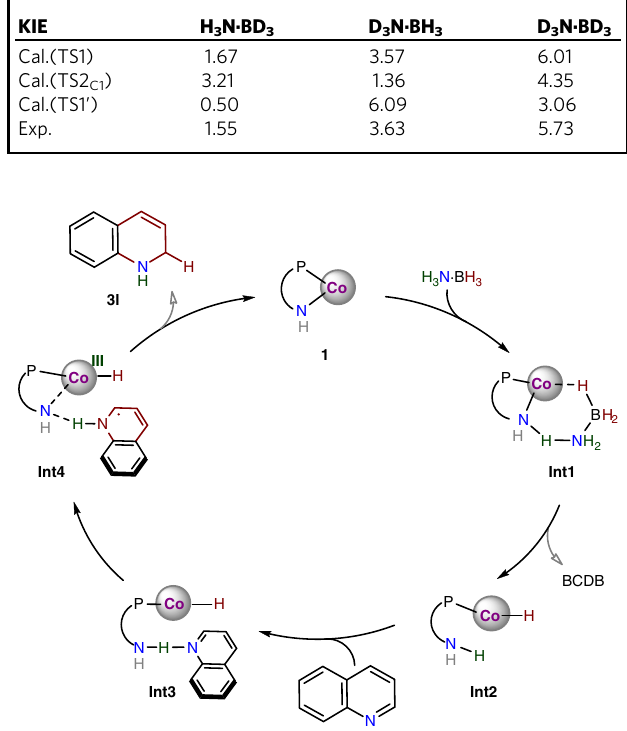
Fig. 8 Proposed Mechanism. Catalytic cycle for partial transfer hydrogenation of quinoline.